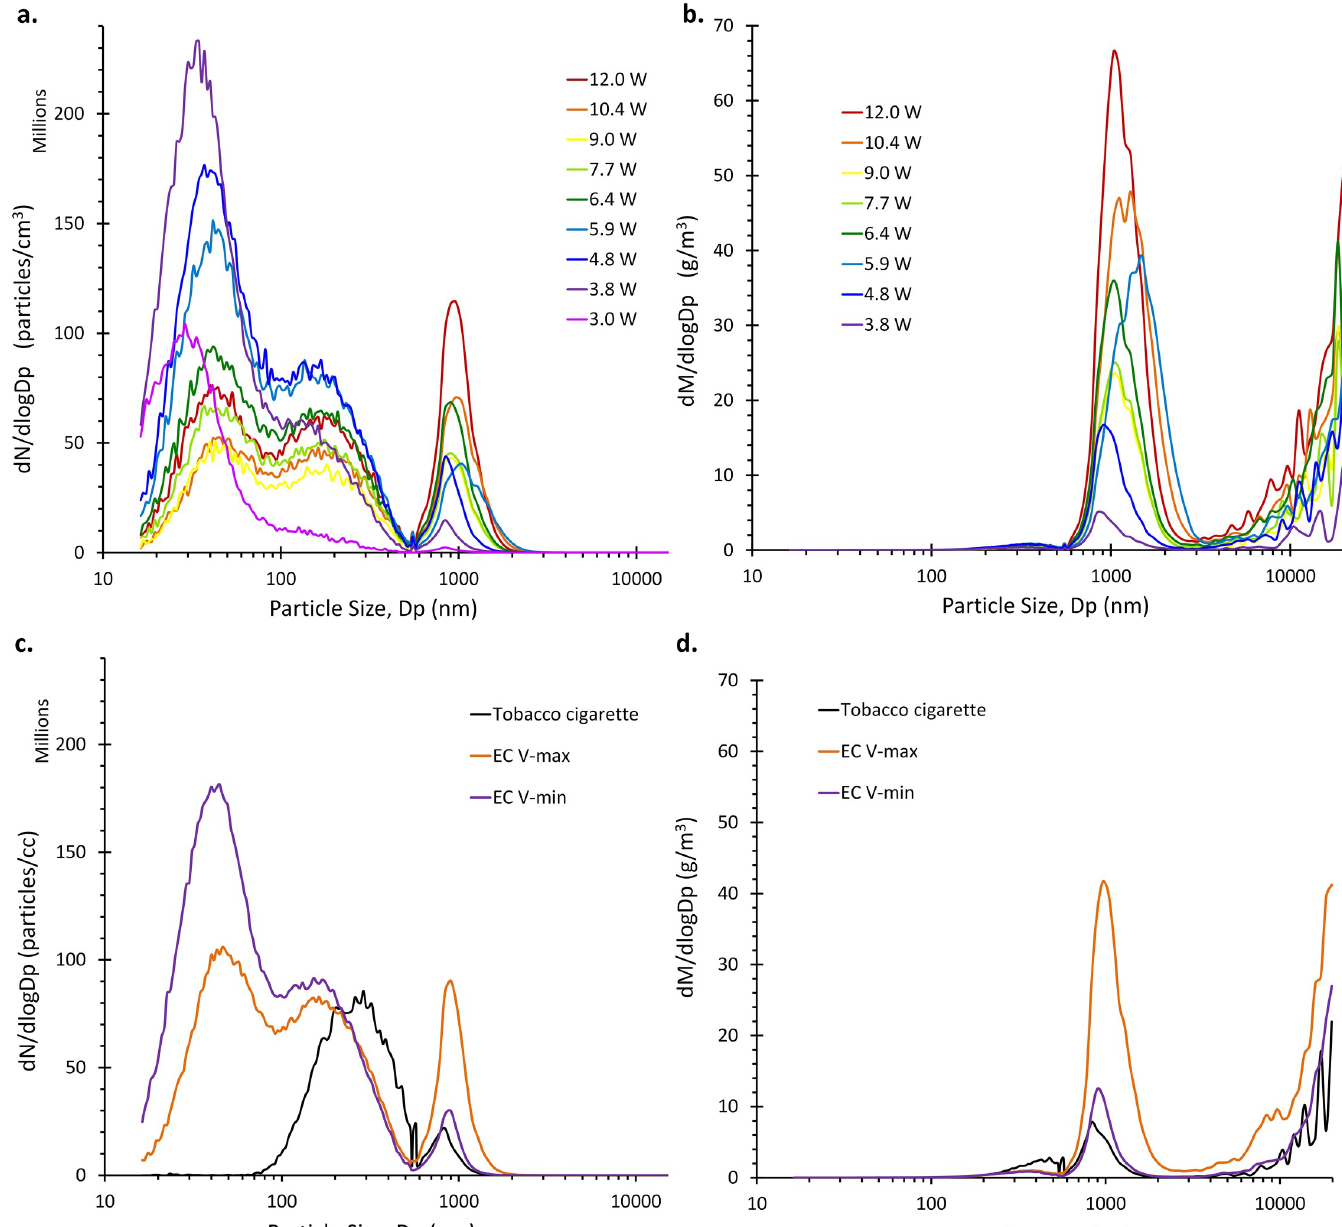
Fig 3. Particle size and mass distributions for EC aerosols and tobacco smoke. a.) EC aerosols produced by a 2 nd generation EC atomizer powered by a laboratory power supply at 9 different levels. Nano-sized particle count decreased as power increased but micron sized particles increased as power increased. b.) Mass distribution of EC aerosol calculated from particle size distribution. Large particles make up the majority of aerosol mass. c.) EC aerosols produced by the same atomizer powered by a variable voltage EC battery at V min and V max dial settings and compared to a Kool Blue cigarette smoke aerosol. Note the distinct difference between EC aerosol and cigarette smoke. Data shown are average of three trials. d.) Mass distribution of EC aerosol and cigarette smoke calculated from particle size distribution. Battery powered EC aerosol has a smaller particle mode around 1 μ m than observed in power supply experiments which may be due to battery underperformance. Data shown are average of three